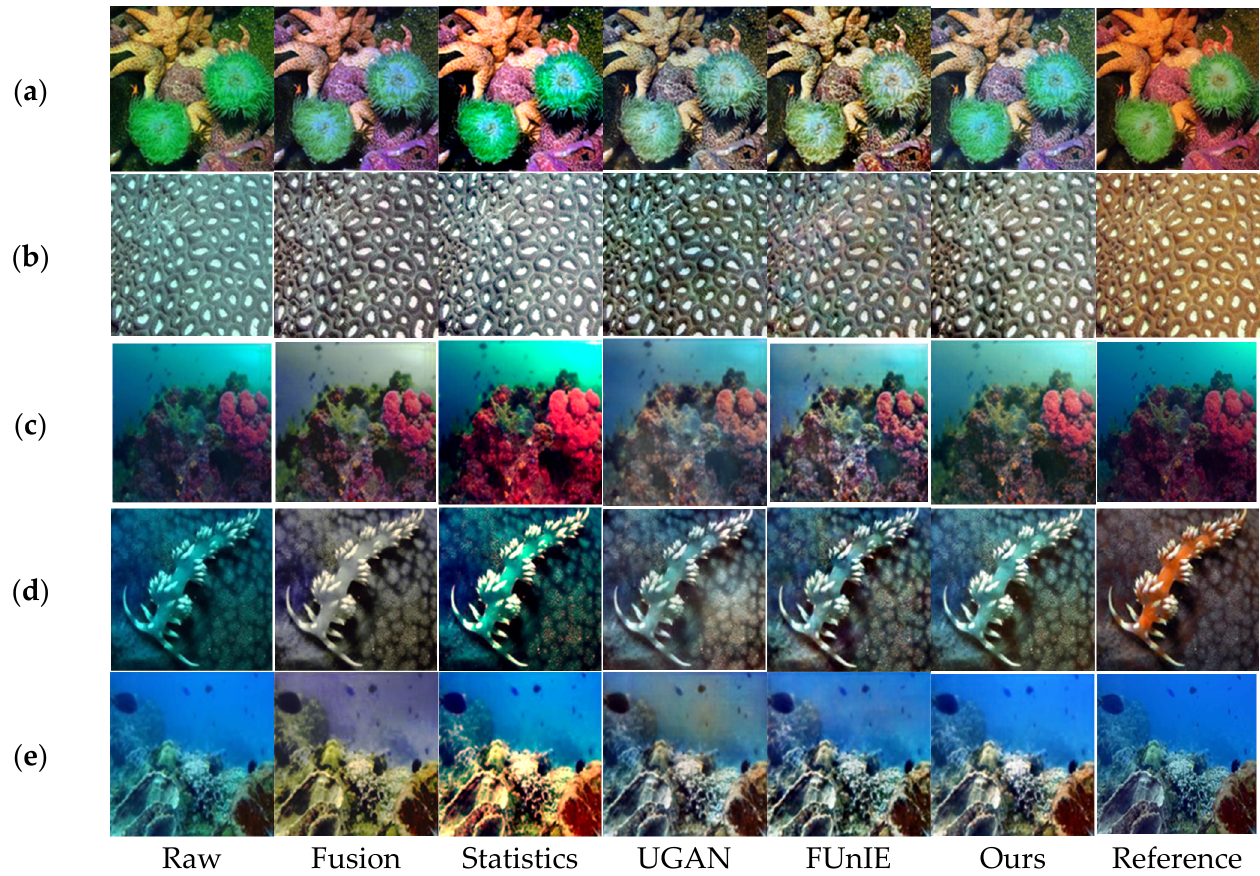
Figure 8. Test results of our method and other comparative methods on the EUVP dataset.